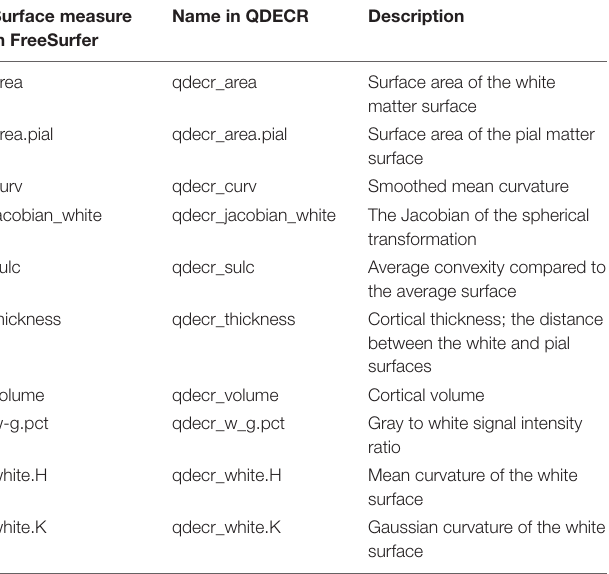
TABLE 2 | Overview of the surface-based measures. Surface measure in